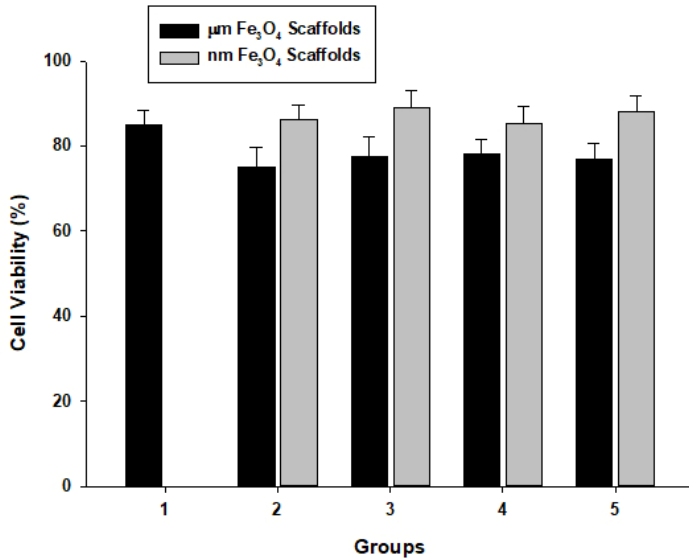
Figure 5. Cell biocompatibility of the magnetic scaffolds with various wt/wt ratios of Fe 3 O 4 particles to PCL, i.e., 0:1 (1), 0.05:0.95 (2), 0.10:0.90 (3), 0.20:0.80 (4), and 0.40:0.60 (5).